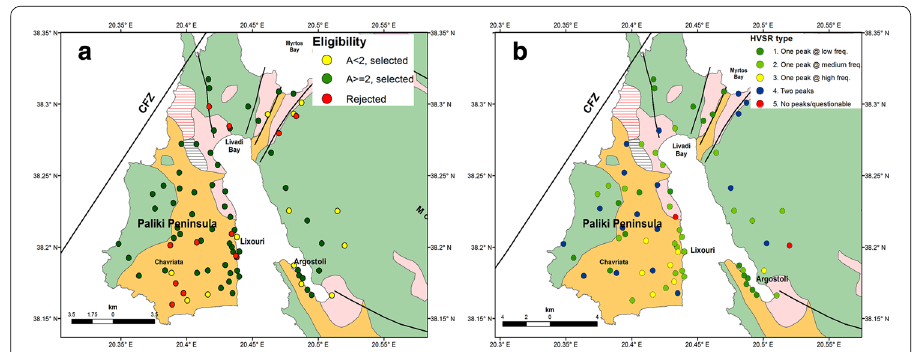
Fig. 5 a Selected points ( solid green and yellow circles ) considered for the site characterization after applying HVSR eligibility criteria [44]. Red circles denote rejected measurements. b The same as in panel a , but present- ing only the 68 selected